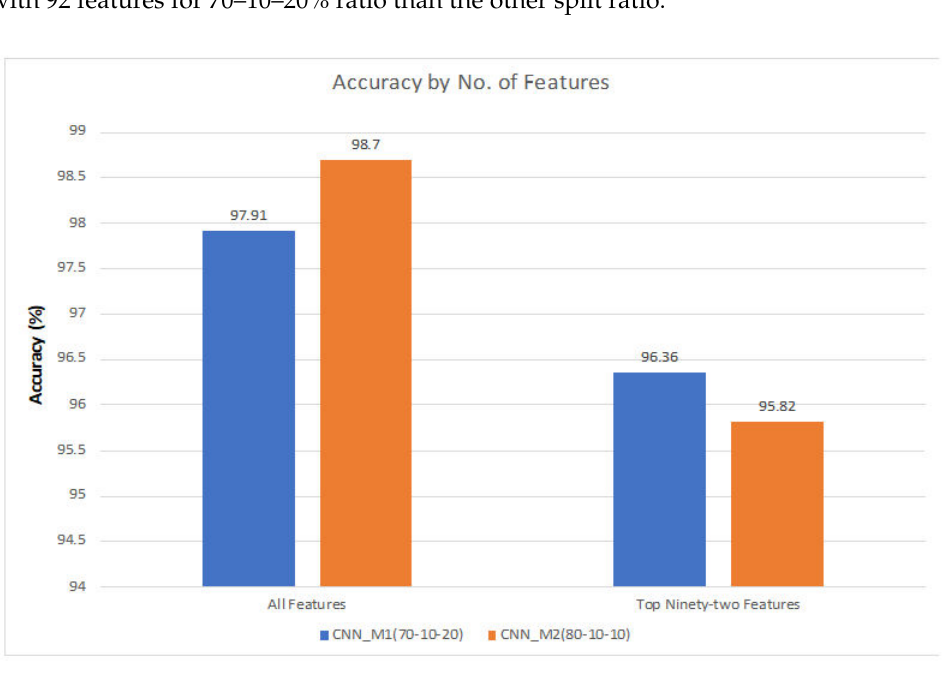
Figure 22. Accuracy by number of features for different split